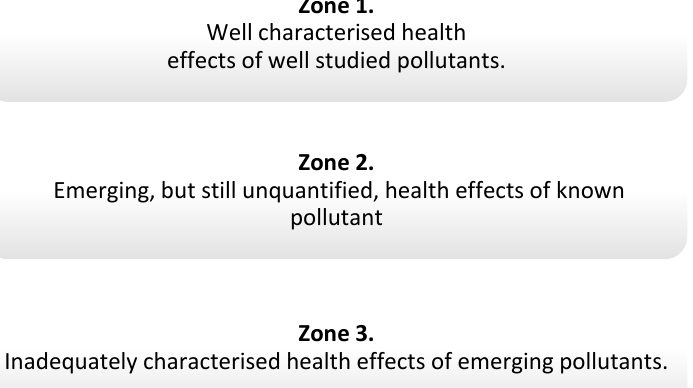
Figure 1. Zones determining the degree of knowledge of pollution according to The Lancet [1]. Endocrine disruptors, including phthalates, phenols, and flame retardants (FRs), are